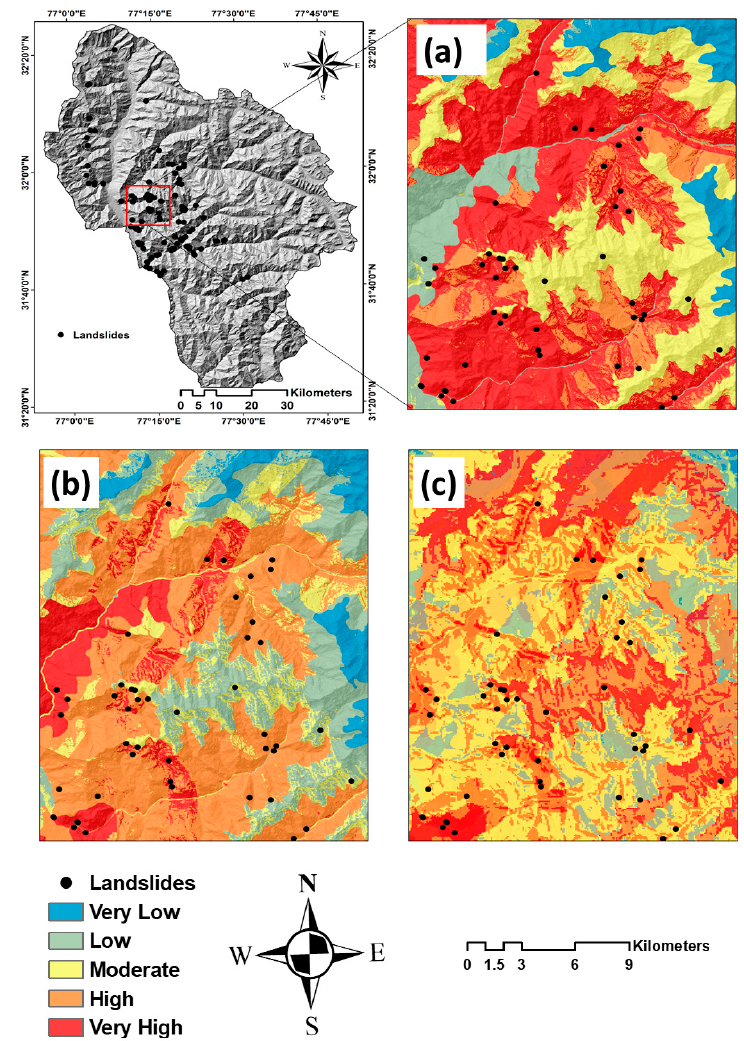
Figure 8. An enlarged sub-area from the resulting landslide susceptibility maps generated based on the three different resolution DEMs: a ) 12.5 m DEM, b ) 30 m DEM and c ) 90 m DEM.